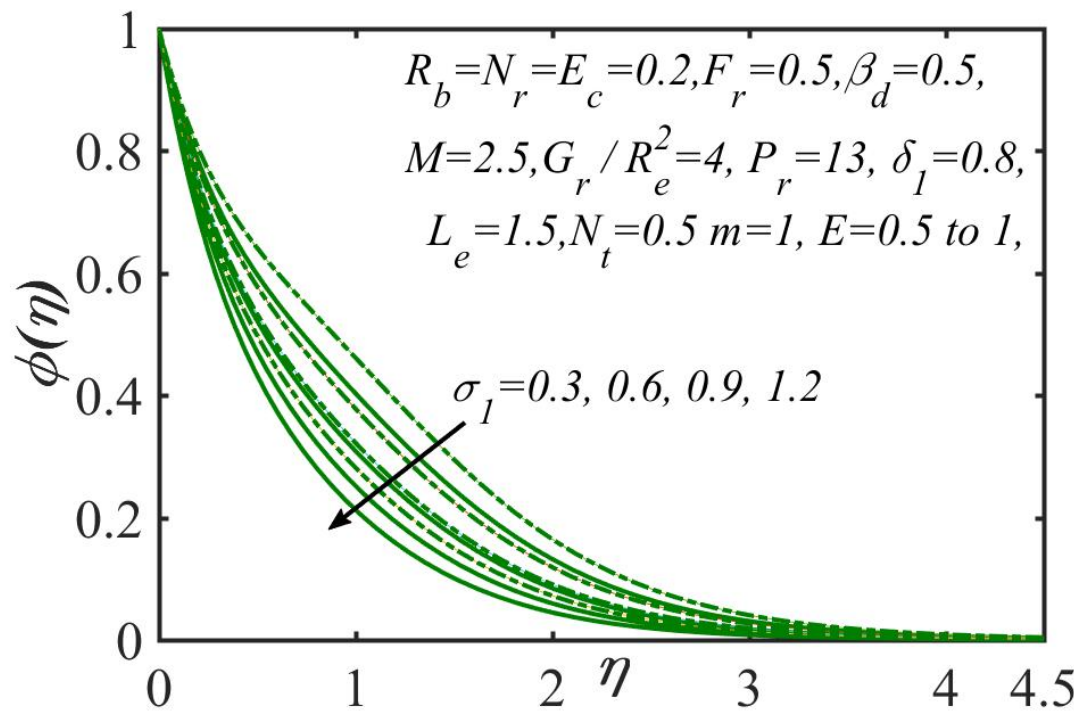
Figure 12. Variation in σ 1 and E on concentration distribution. Solid line: E = 0.5, Dotted line: E = 1.0.